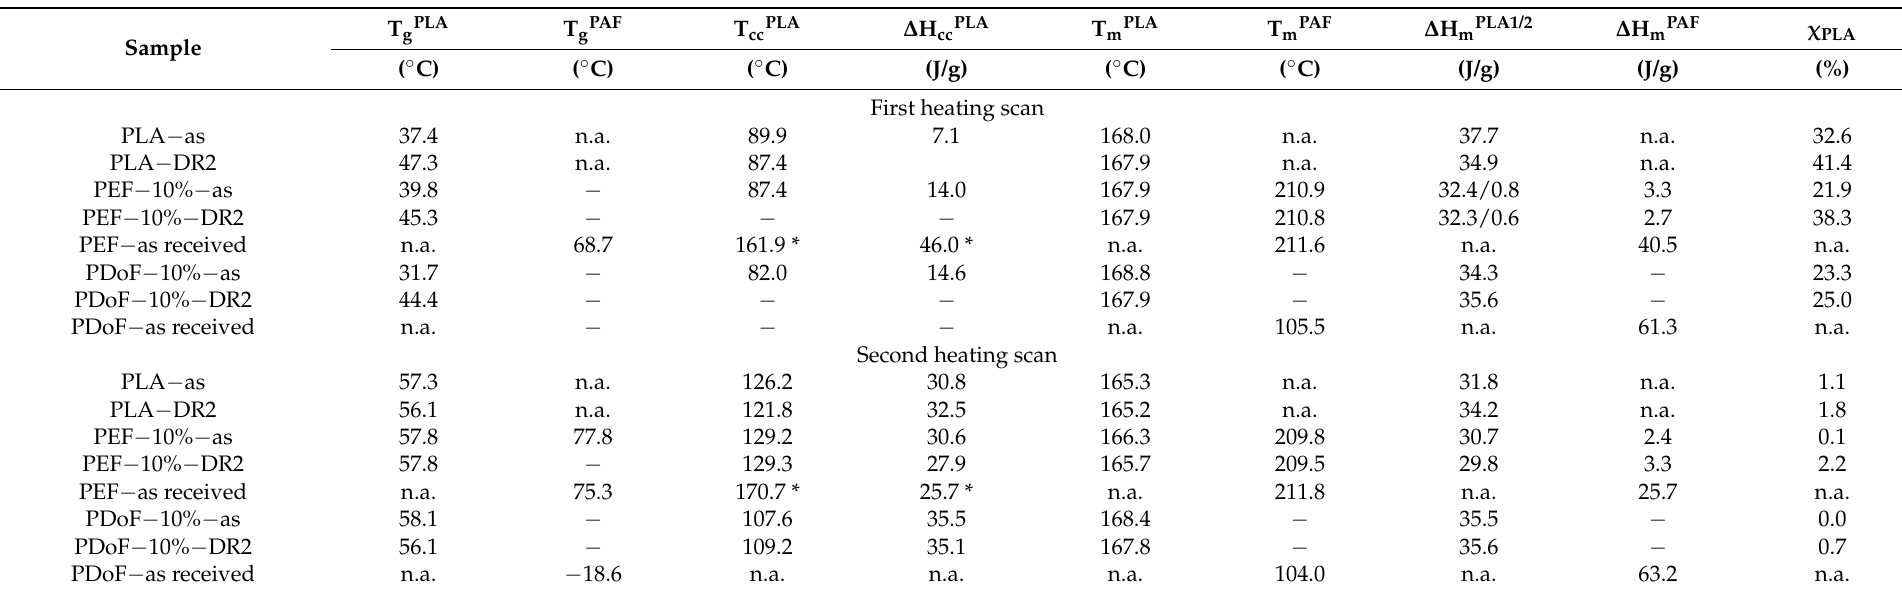
Table 4. Results of DSC tests of the PLA − as, PEF − 10% − as, PEF − 10% − DR2, and PEF − as received samples, and of PDoF − 10% − as, PDoF − 10% − DR2,